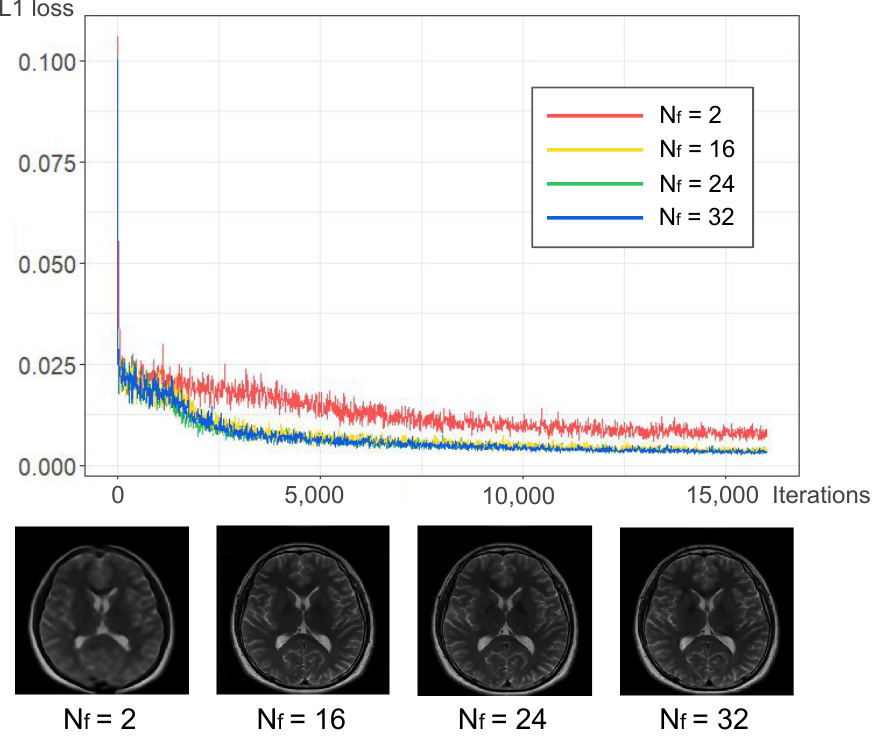
Figure 3. Learning curve of the proposed network corresponding to four different channel sizes: N f = 2, 16, 24, and 32. The reconstructed images are shown for different N f